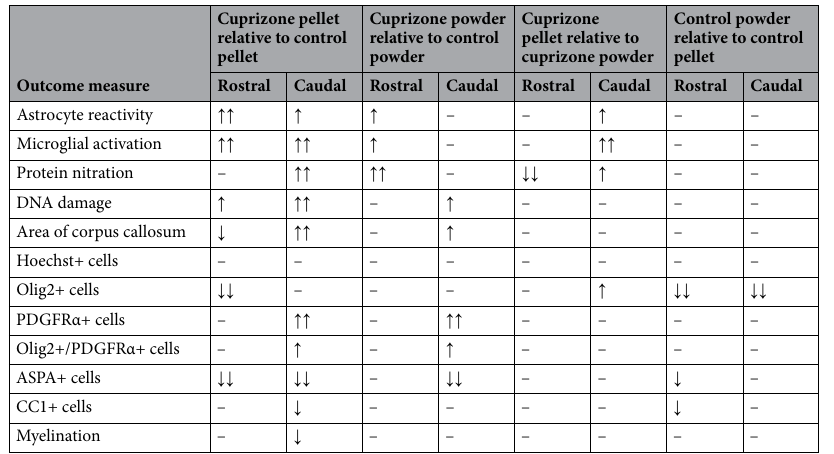
Table 1. Summary of immunohistochemical and histological outcomes. Arrows ↑ and ↓ represent a statistically significant increase or decrease and – represents no significant difference. Single arrows represent p values of greater than 0.001 and less than 0.05, whilst double arrows represent p values ≤